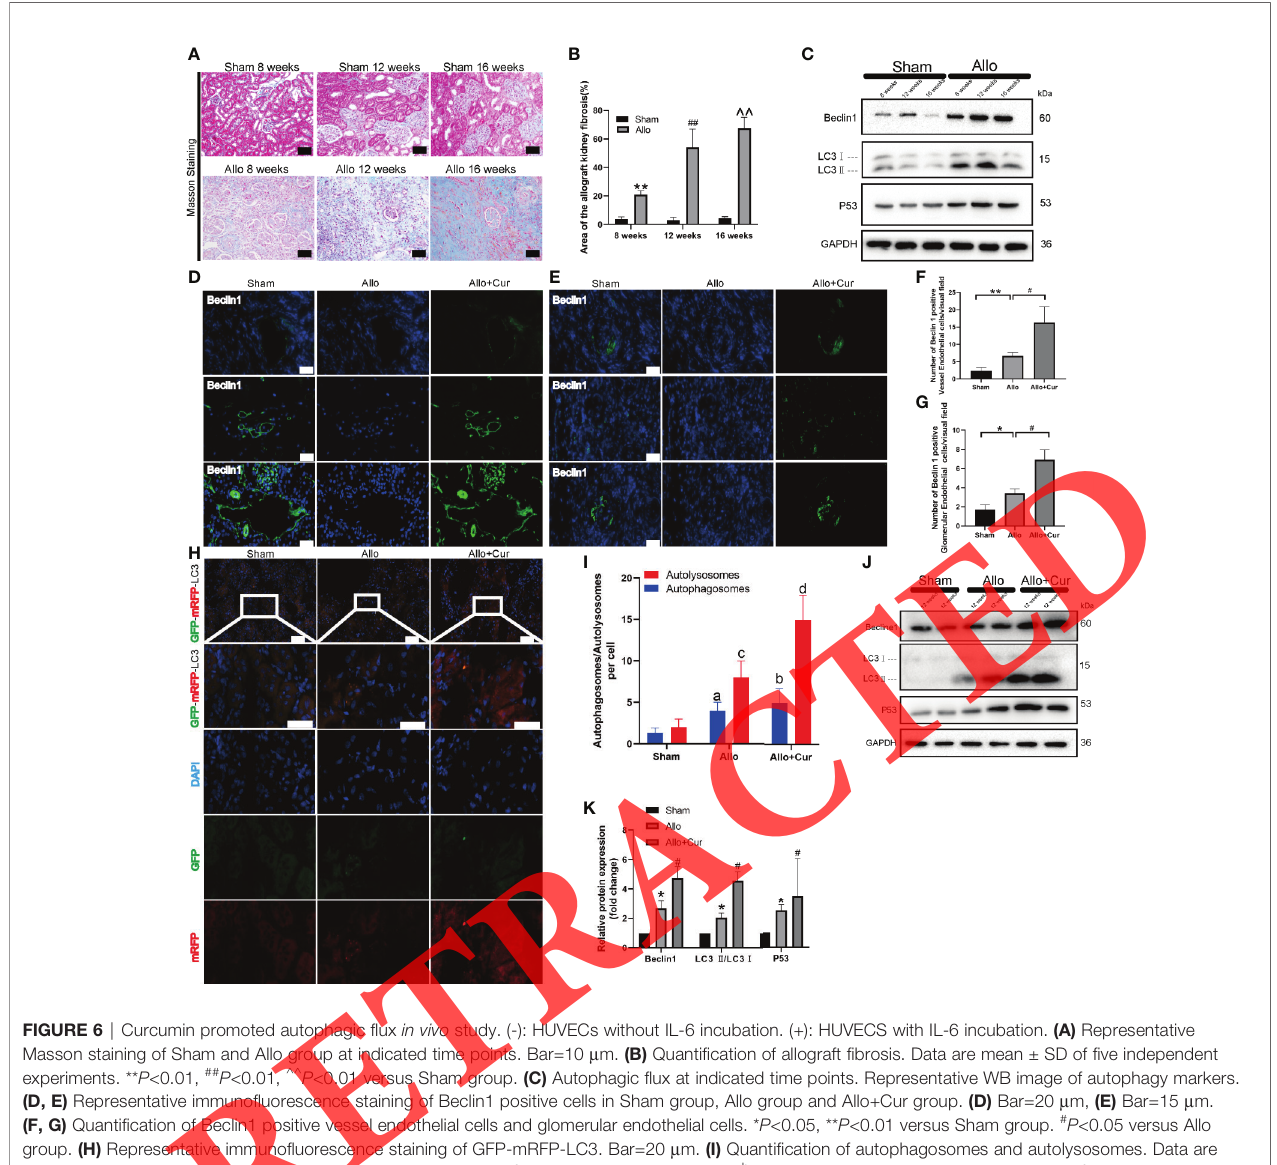
FIGURE 6 | Curcumin promoted autophagic fl ux in vivo study. (-): HUVECs without IL-6 incubation. (+): HUVECS with IL-6 incubation. (A) Representative Masson staining of Sham and Allo group at indicated time points. Bar=10 m m. (B) Quanti fi cation of allograft fi brosis. Data are mean ± SD of fi ve independent experiments. ** P <0.01, ## P <0.01, ^^ P <0.01 versus Sham group. (C) Autophagic fl ux at indicated time points. Representative WB image of autophagy markers. (D, E) Representative immuno fl uorescence staining of Beclin1 positive cells in Sham group, Allo group and Allo+Cur group. (D) Bar=20 m m, (E) Bar=15 m m. (F, G) Quanti fi cation of Beclin1 positive vessel endothelial cells and glomerular endothelial cells. * P <0.05, ** P <0.01 versus Sham group. # P <0.05 versus Allo group. (H) Representative immuno fl uorescence staining of GFP-mRFP-LC3. Bar=20 m m. (I) Quanti fi cation of autophagosomes and autolysosomes. Data are mean ± SD of fi ve independent experiments. Autophagosomes: a P <0.05 versus Sham group. b P >0.05 versus Allo group. Autolysosomes: c P <0.05 versus Sham group. d P >0.05 versus Allo group. (J) Findings of WB con fi rmed our immuno fl uorescence results. (K) Quanti fi cation of relative protein abundance of autophagy marker. Data are mean ± SD of fi ve independent experiments. * P <0.05 versus Sham group. # P <0.05 versus Allo